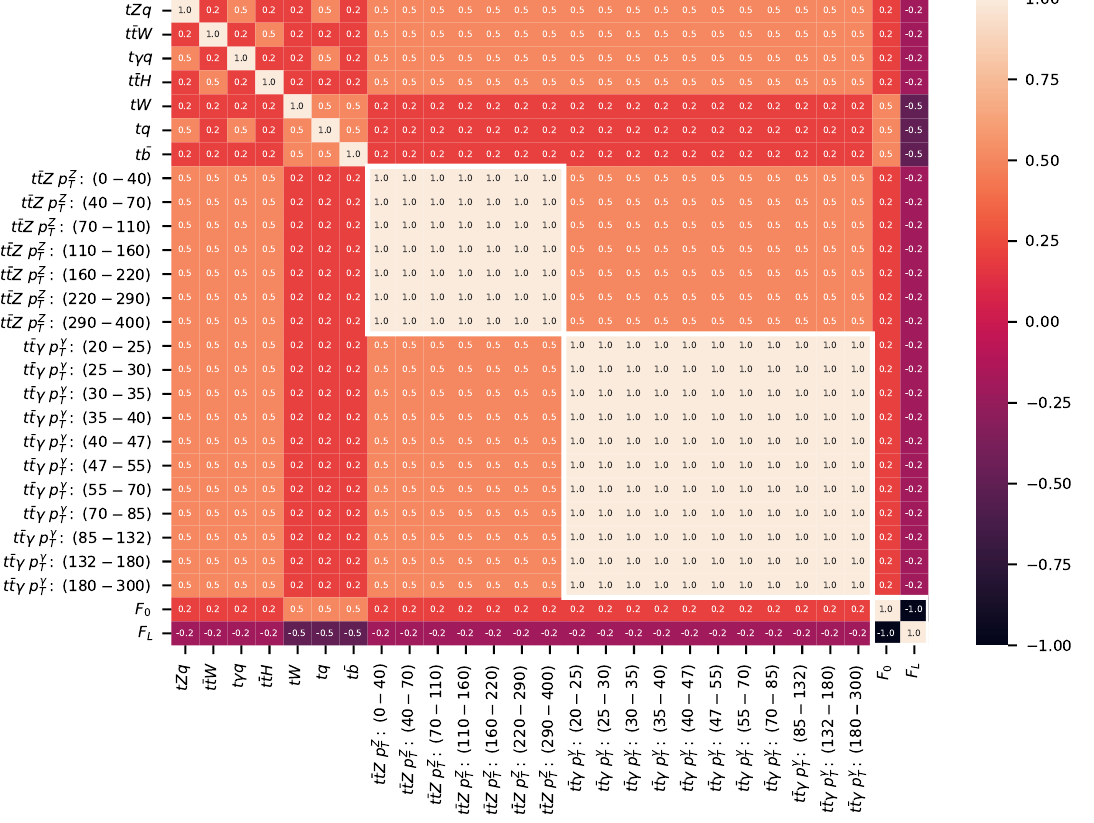
Figure 6 . Theoretical correlation matrix used. The boxes in white correspond to the correlations between the differential bins in t ¯ tZ and t ¯ tγ ( W boson helicity fractions) and a 100% ( − 100 %) correlation is assumed among them. The rest of the entries correspond to our ansatz, as described in section 8.3. Cells are filled if the correlation is higher than 10% in absolute